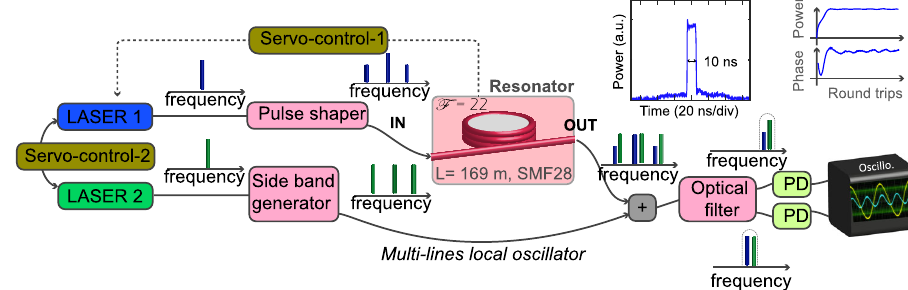
Fig. 3 Experimental setup. Simpli fi ed sketch of the experimental setup. A multi-heterodyne system, inspired from 34 , had been implemented to trigger and analyze the modulation instability effect and to analyze the output cavity fi eld in real time (see top right examples of power and phase evolutions). We launched 10 ns pulses (see central panel) to avoid stimulated Brillouin scattering. F: Finesse, L: cavity length, SMF: single mode fi ber 28, div : division, PD: photo-detector, and Oscillo: